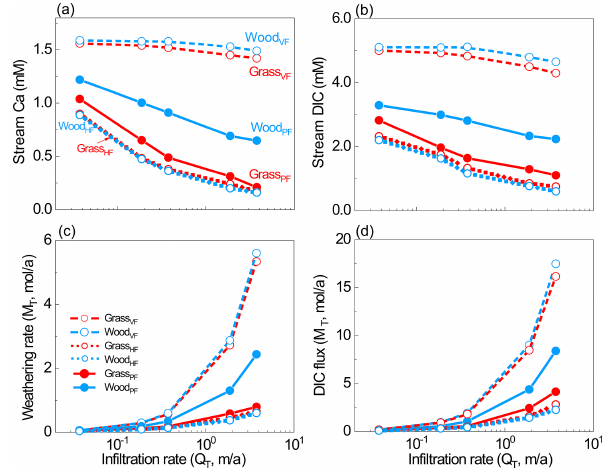
Figure 4. (a–b) Stream water Ca and DIC concentrations, and (c– d) stream fluxes from all scenarios. Stream water was the overall effluent from soil water and groundwater. The differences caused by hydrological differences (VF, HF, and PF) were much larger than the differences within each pair with the same flow partitioning, indicating significant hydrological impacts on weathering.